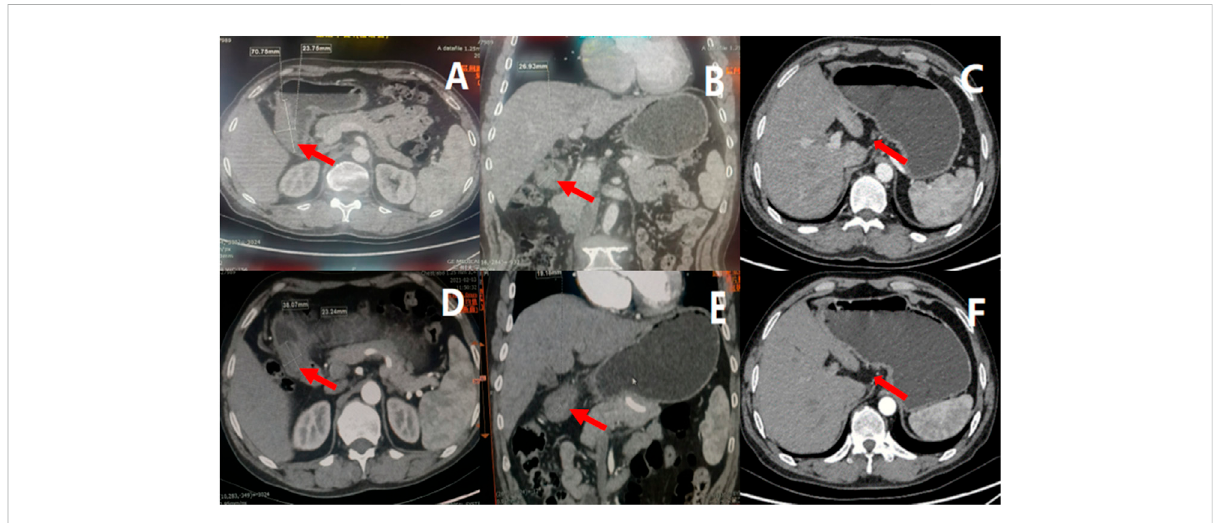
FIGURE 3 Results of enhanced CT before and after neoadjuvant therapy, indicated tumor and lymph node volume decreased after three cycles of treatment. (A) showed the cross section of gastric antrum tumor before treatment, (B) showed the coronal view of gastric antrum tumor before treatment, (C) showed the enlarged lymph nodes before treatment; (D) showed the cross section of gastric antrum tumor after neoadjuvant treatment, (E) showed the coronal view of gastric antrum tumor after neoadjuvant treatment, (F) showed the enlarged lymph nodes after neoadjuvant treatment.